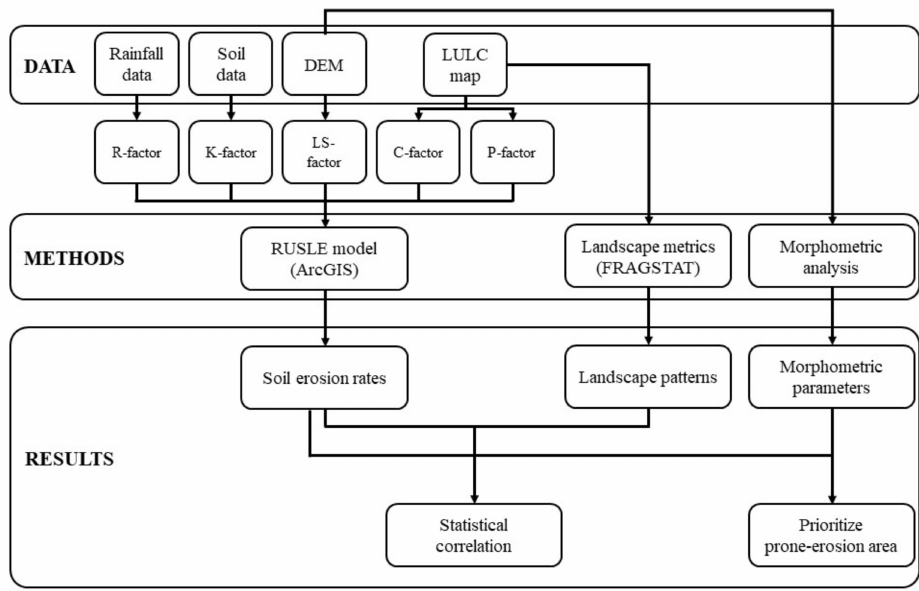
Figure 2. Flowchart of the research